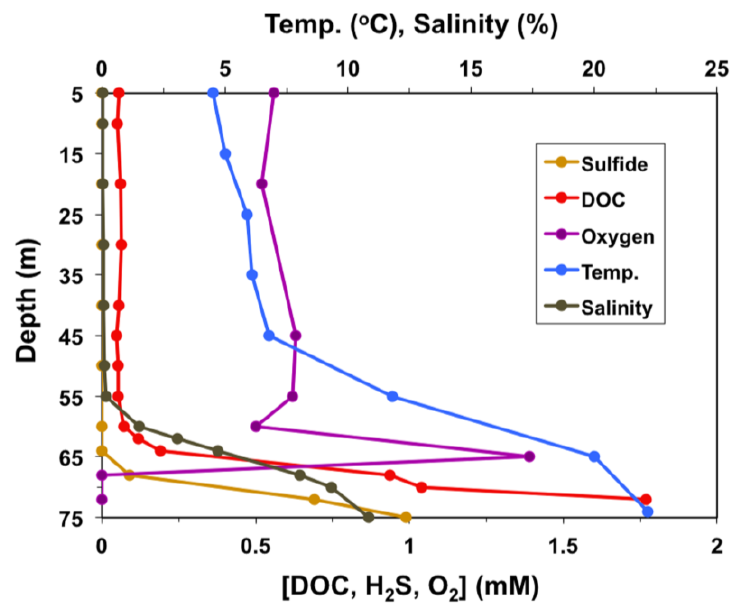
Figure 1. Physiochemical profile of the Lake Vanda water column. Due to the permanent ice cover on Lake Vanda, measurements begin at a depth of 5